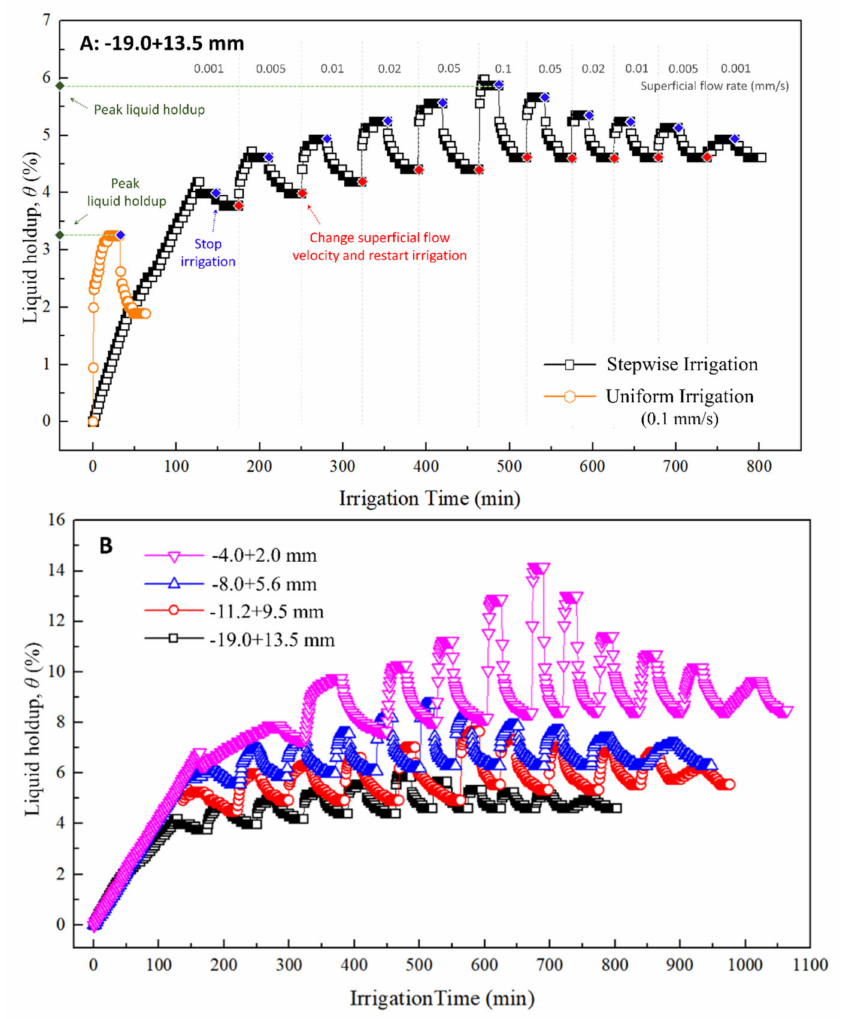
Figure 3. The changes of liquid holdup in a dry ore bed during stepwise irrigation. ( A ): typical changes of liquid holdup in a dry ore bed ( − 19.0 + 13.5 mm), ( B ): changes of liquid holdup under different particle size